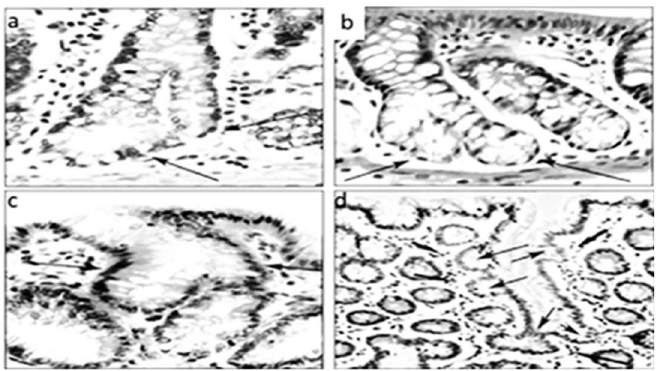
Fig 2. Corrupted colonic crypts showing asymmetric fission (a, b and c) and asymmetric lateral sprouting (d) at arrows (DMH-treatedrats, hematoxylin-eosin, a, b and c: x20, d: x10).